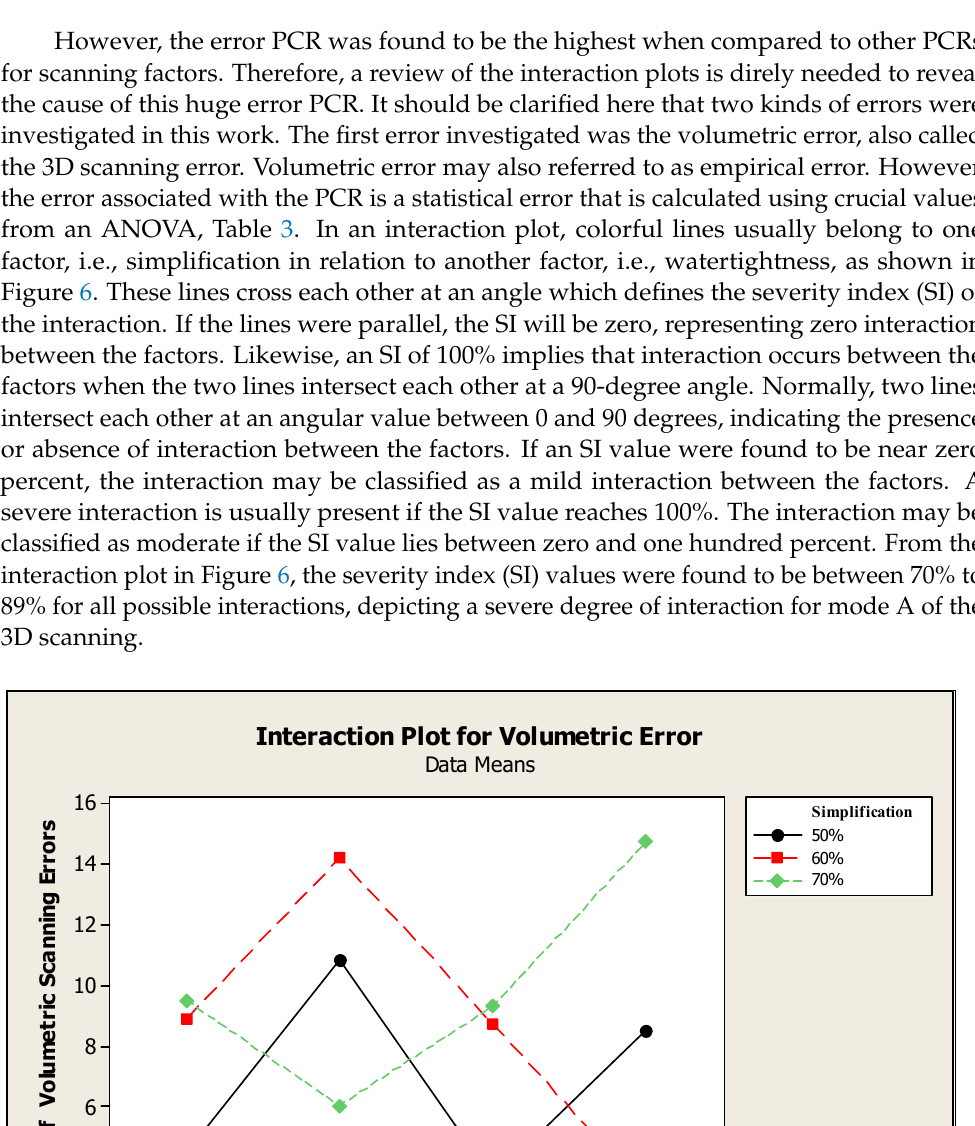
Figure 6. Interaction plots for volumetric error (Mode